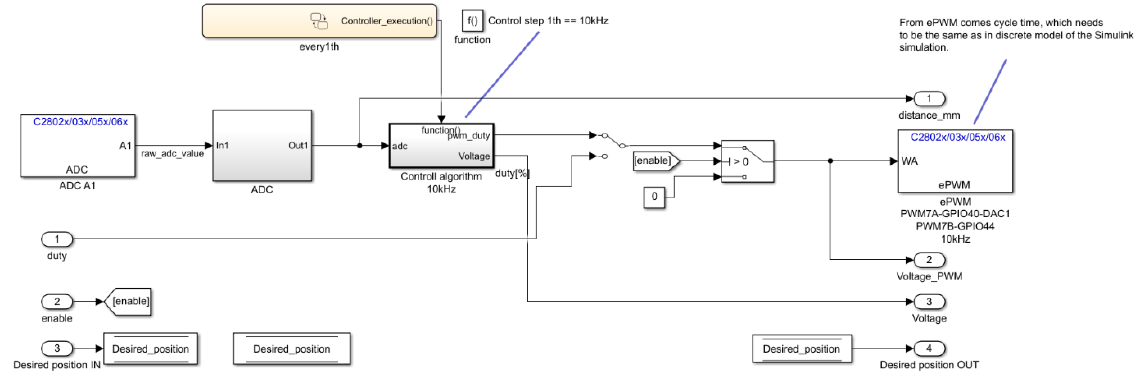
Figure 7. Reading real time measurements from DSP in Matlab/Simulink.